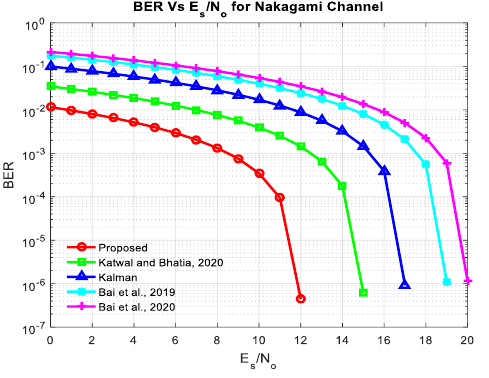
Figure 16. BER vs. E